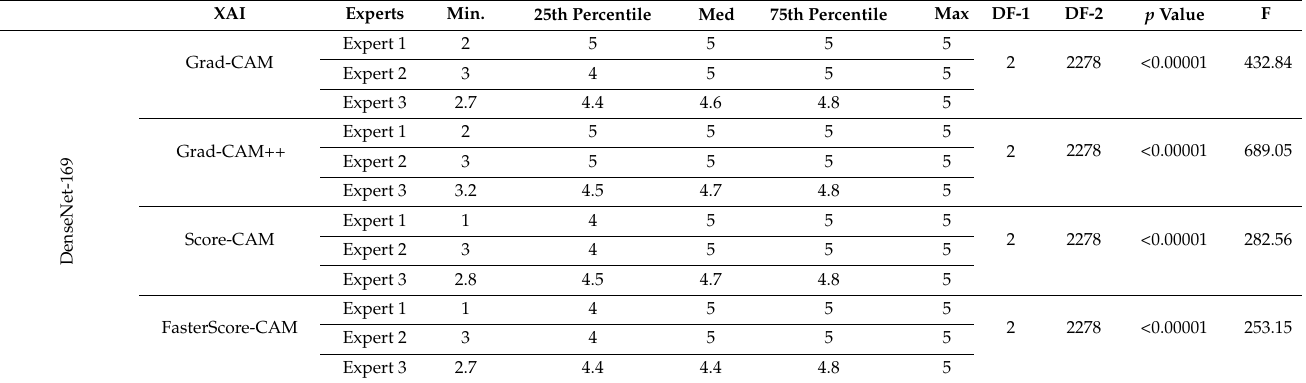
Table A2. Friedman test using DenseNet-169 model on the MAI score from three